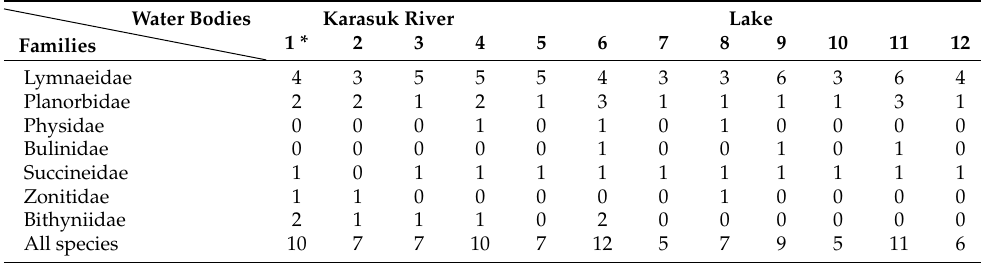
Table 2. Number of gastropod species in water bodies of northern Kulunda in